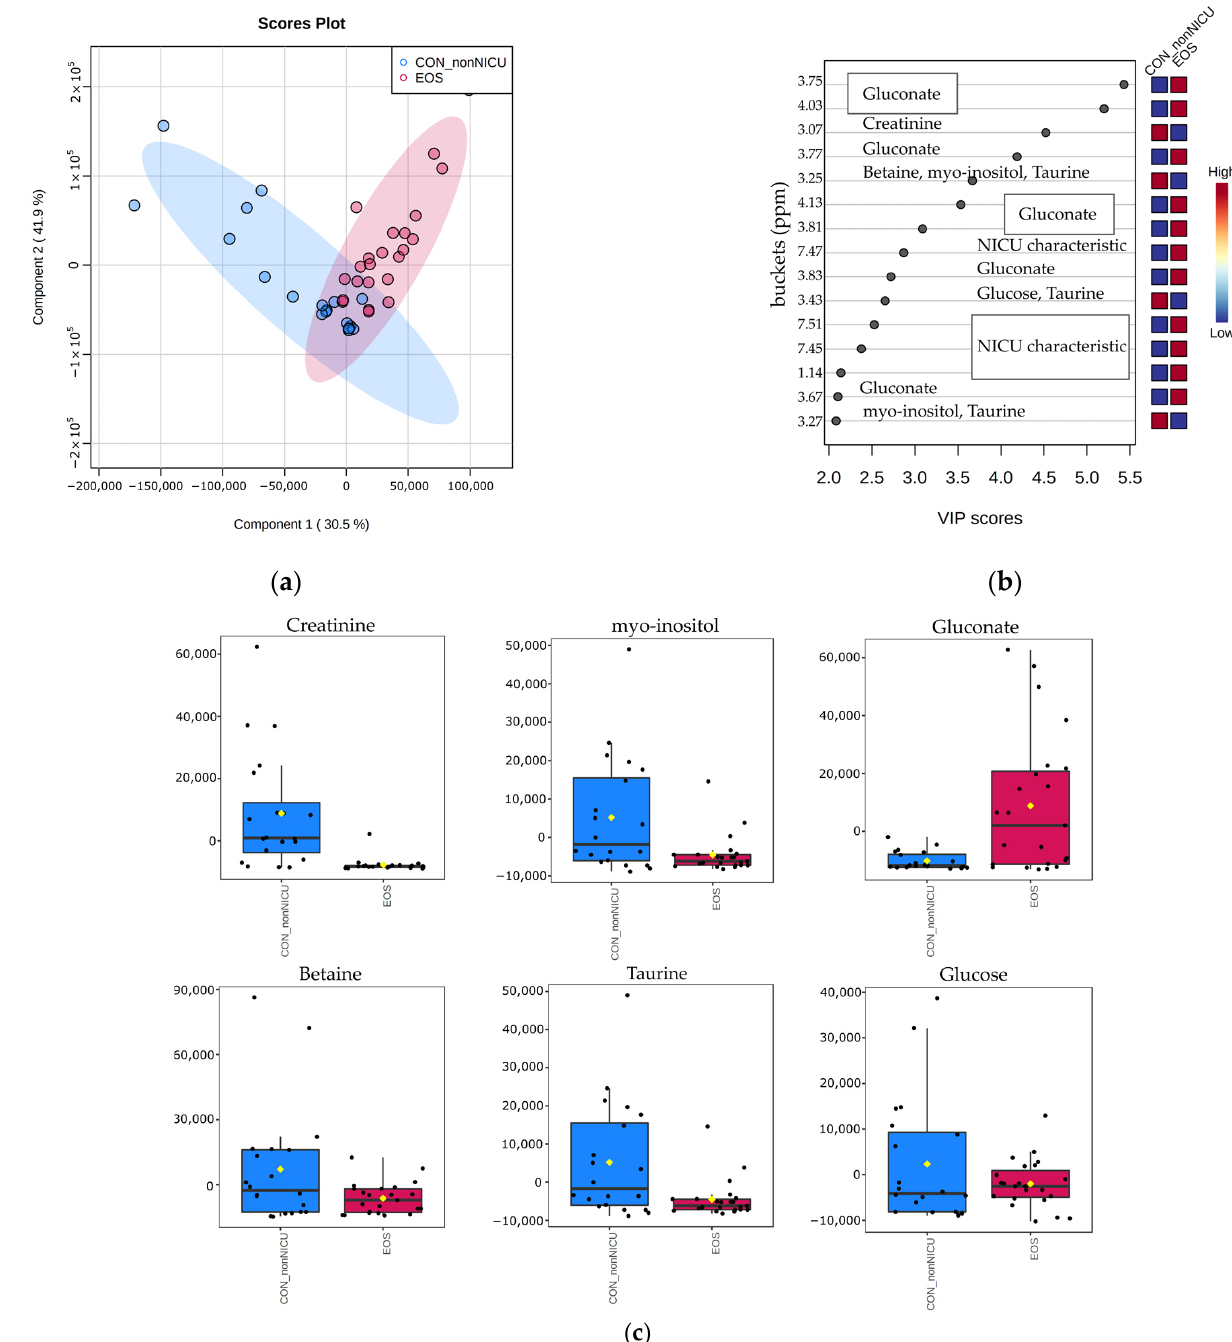
Figure 1. Multivariate analysis of NMR data belonging to neonates diagnosed with EOS (pink circles) and healthy neonates without need for NICU hospitalization (blue circles). ( a ) PLS-DA scores plot of the EOS and healthy non-NICU preterms. ( b ) VIP scores and metabolites related to buckets with different concentration among the two groups. ( c ) Box plots of normalized concentration for the discriminant metabolites.